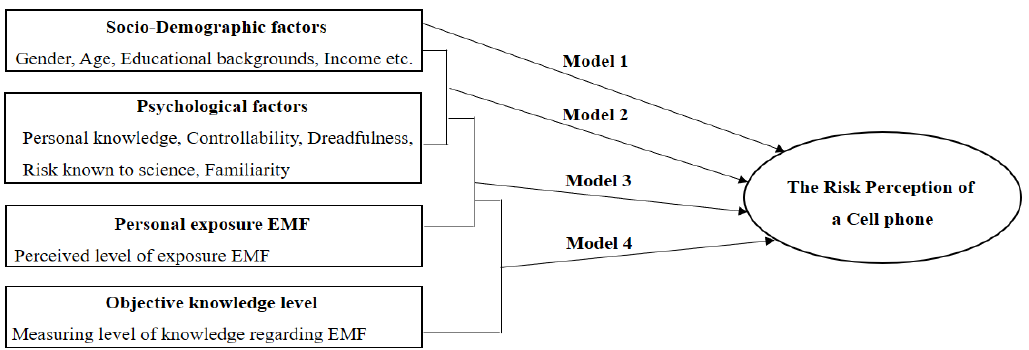
Figure 1. Conceptual model of research on risk perceptions of cell phones. EMF: Electromagnetic Fields.